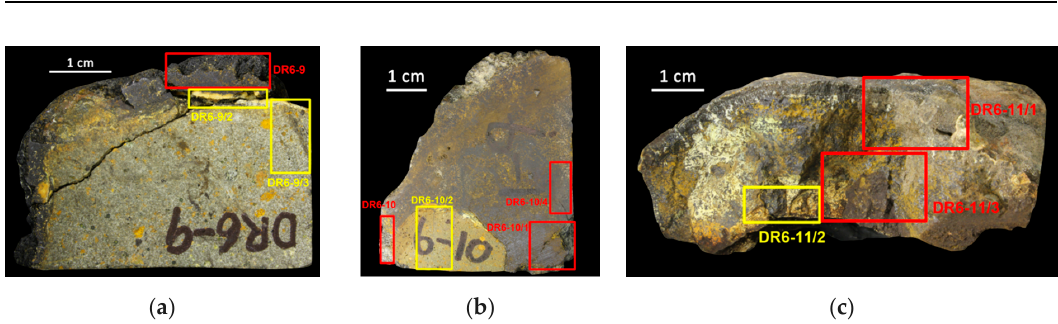
Figure 2. Representative cut sections of ferromanganese crusts from the DHR; ( a ) DR6-9; ( b ) DR6-10; ( c ) DR6-11. The red rectangles mark crusts subsamples selected for the XRD, DTA, XRF, ICP-MS and EPMA analyses. Yellow rectangles show places chosen for the substrate-crust alteration zone description, preparation of thin sections, XRD and EPMA.